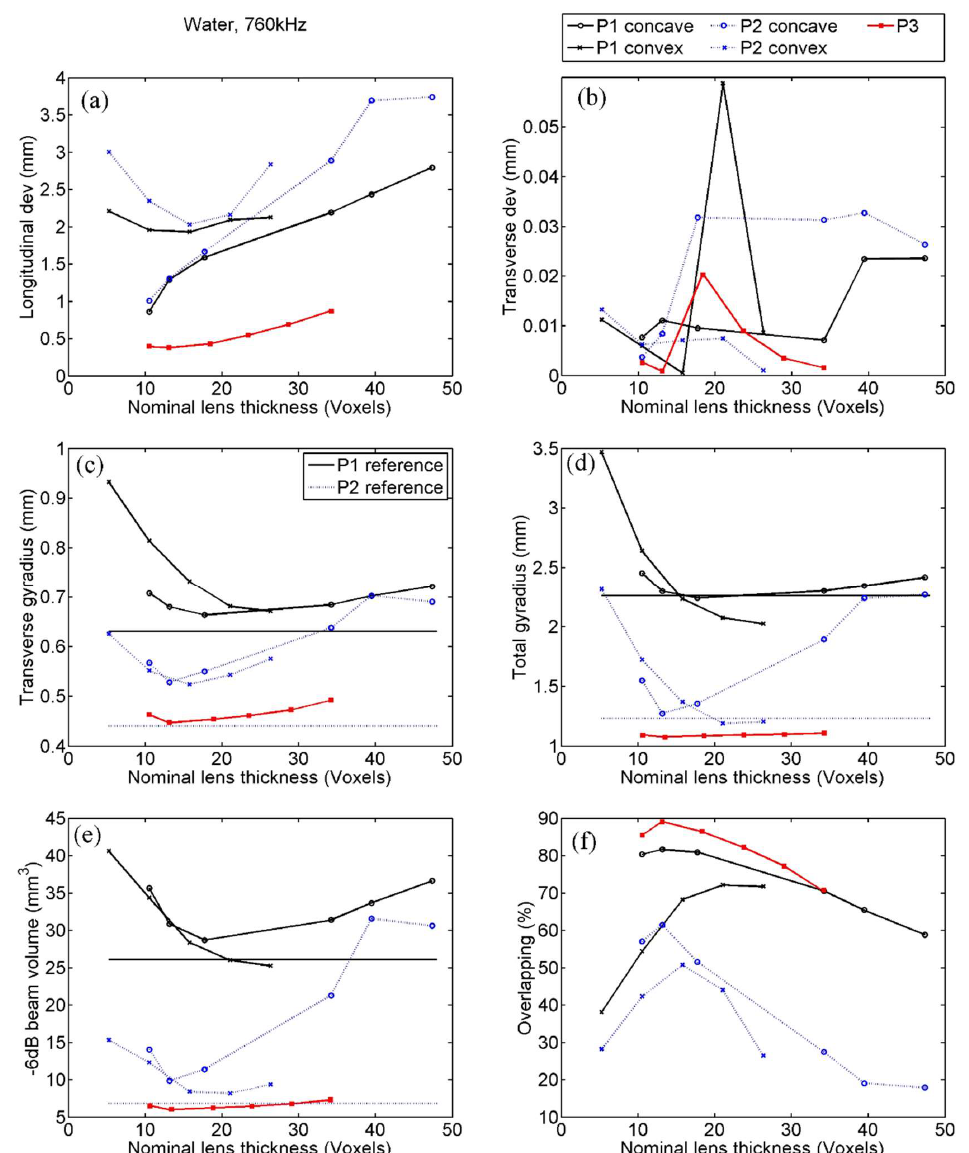
Figure 5. Focusing quality indicators calculated by simulation in water with 760 kHz, at points P1, P2, and P3, for concave (fast) and convex (slow) lenses. Indicators are as follows: ( a ) Longitudinal and ( b ) transverse deviation, ( c ) transverse and ( d ) total gyradius, ( e ) beam volume, and ( f ) energetic overlapping.